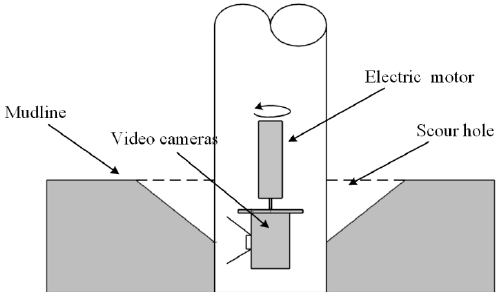
Figure 17. Schematic diagram for monitoring the effect of the scour around the foundation.